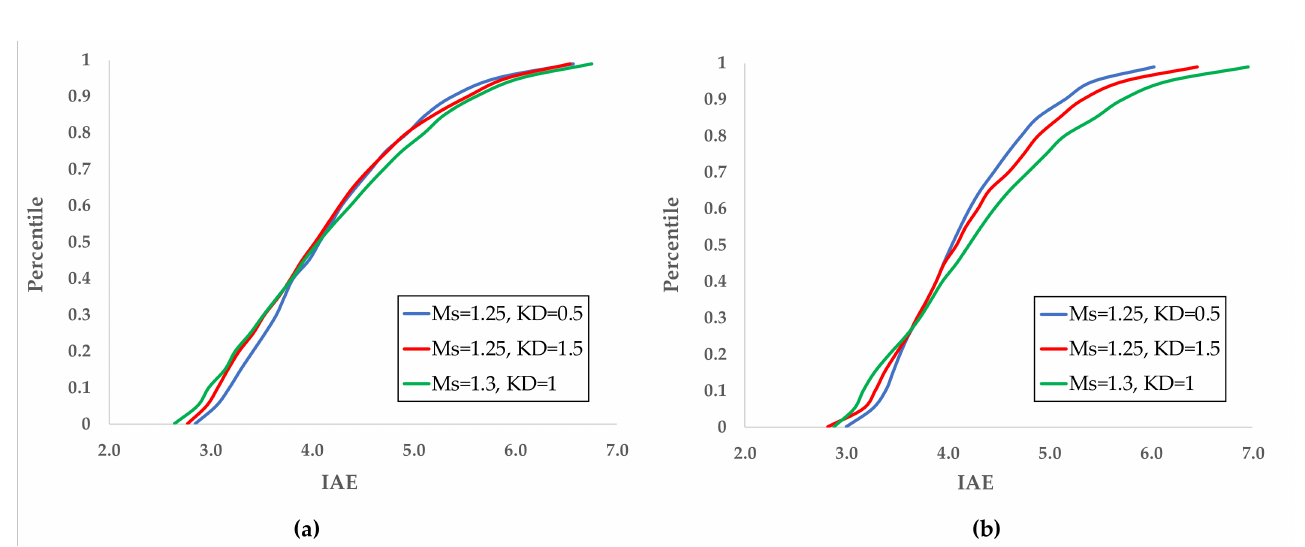
Figure 11. IAE distributions for SP a : ( a ) 400 mm H 2 O; ( b ) 375 mm H 2